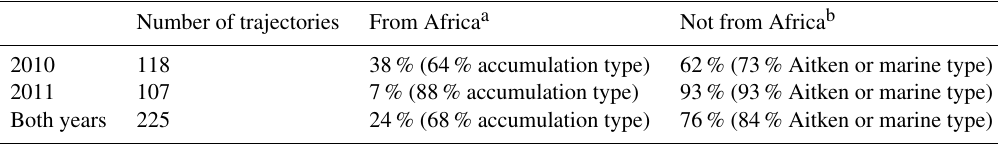
Table 3. Statistics on trajectories. (Percentages in brackets indicate the proportion of the total, given before the brackets, for each type.)